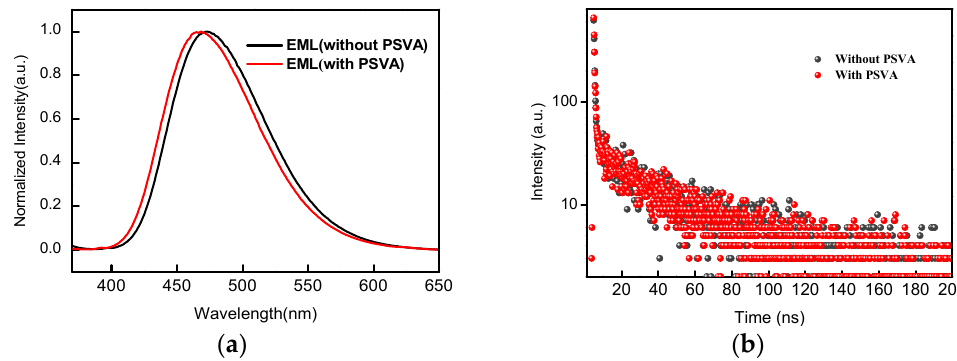
Figure 6. ( a ) PL spectra of mCP: 20 wt% DMAC-DPS films with or without PSVA; ( b ) transient PL decay of mCP: 20 wt% DMAC-DPS films at room temperature.